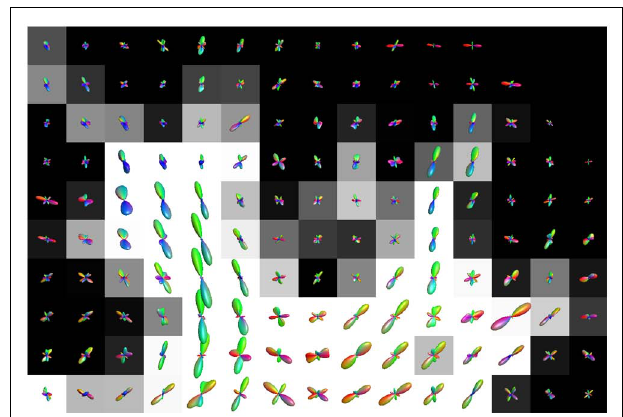
FIGURE 7 | Illustration of the effects of isotropic non-WM PVEs with GM in superior corona radiata with real data. WM tissue probability map estimated from high-resolution anatomical MRI is visualized in the background, and fODFs estimated with CSD using up to eighth-order SH are overlaid.